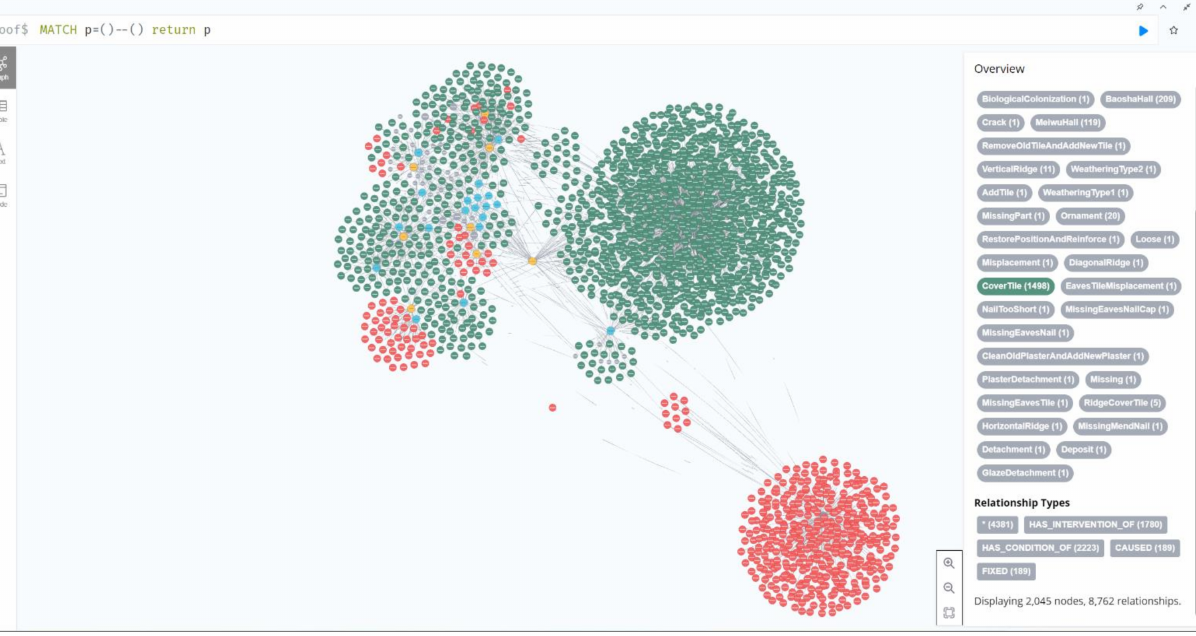
Figure 12. Knowledge graph of all conditions and interventions in